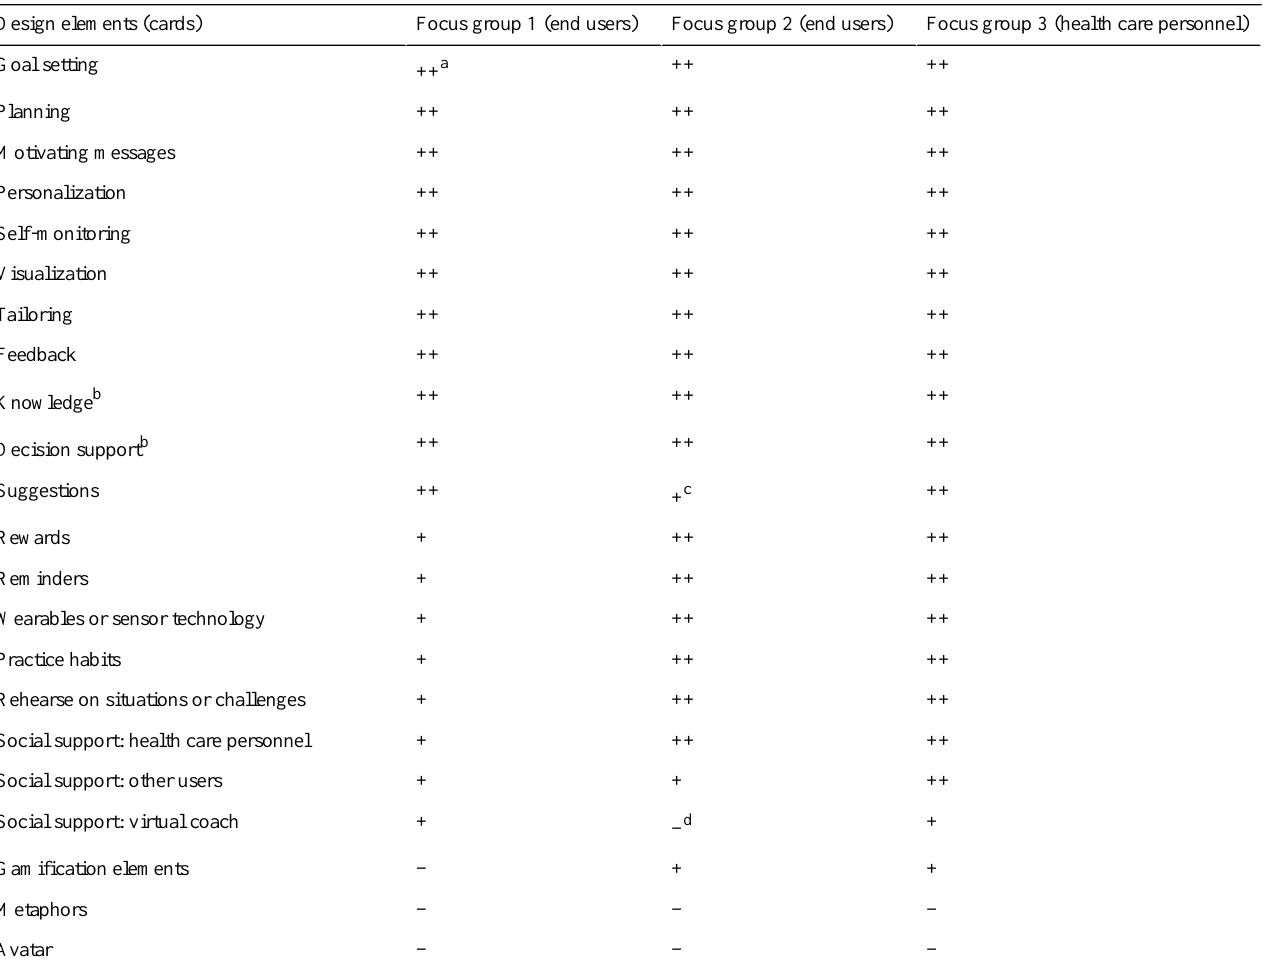
Table 1. Focus group results with identified design